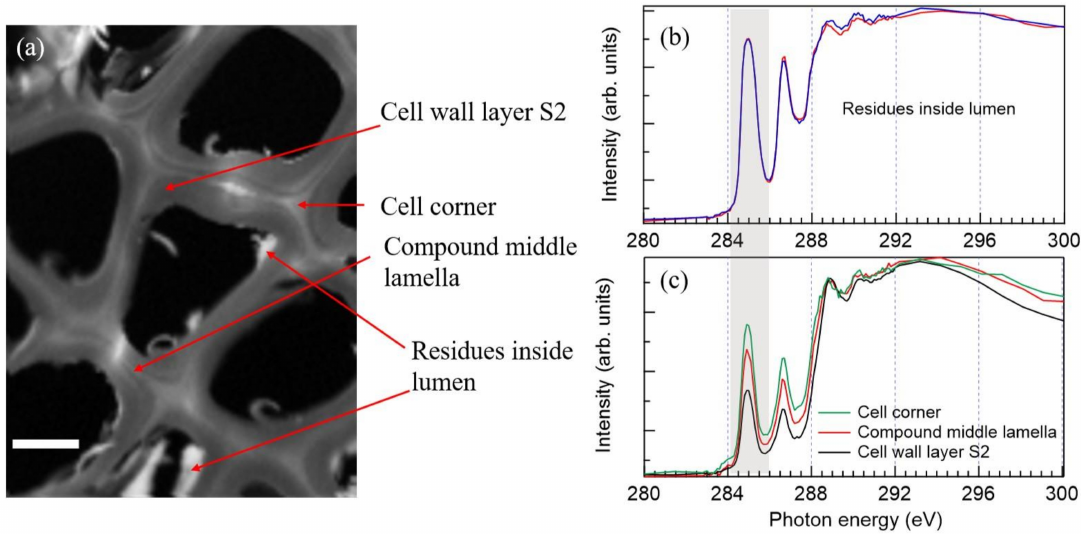
Figure 2. ( a ) An average scanning transmission X-ray microscopy (STXM) image of the cryosectioned knotwood section recorded at the lignin and lignan fingerprint regions at 284.7–285.5 eV. The scale bar is 4 µ m. Arrows indicate the areas from where the C 1s XAS presented in ( b , c ) were obtained. ( b ) C 1s XAS of two regions with deposits inside the cell lumen. ( c ) C 1s XAS of selected regions: cell corner (green), compound middle lamella (red), secondary cell wall layer S2 (black). The spectra were normalised to have the same intensity at 288.9 eV to better visualise how the increasing lignin concentration is directly visible from the spectrum. The aryl-C,H peak used in the composition analysis has been highlighted with a grey